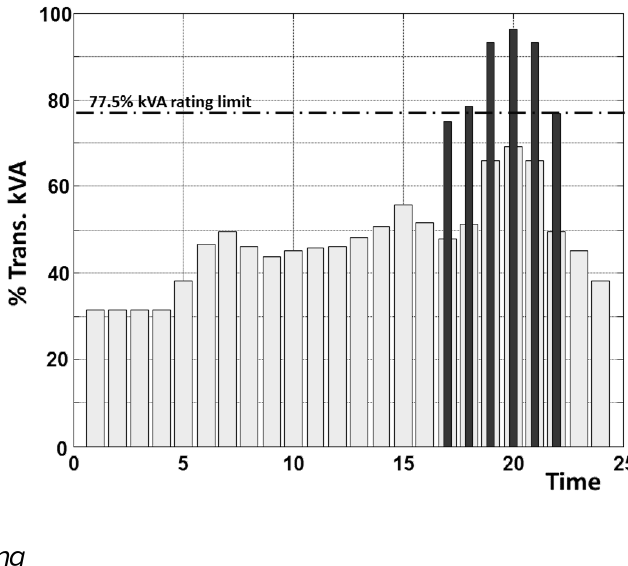
Figure 4. Distribution transformer load profile with 100% penetration of PEVs under uncontrolled charging